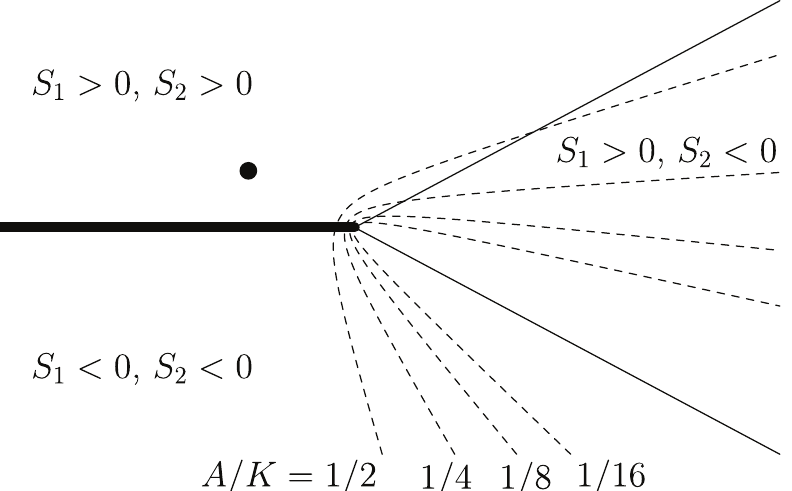
Figure 2. Contribution of acoustic source and image in different regions. Thick line: plate; solid lines: S 1,2 = 0; dashed lines hyperbolae of